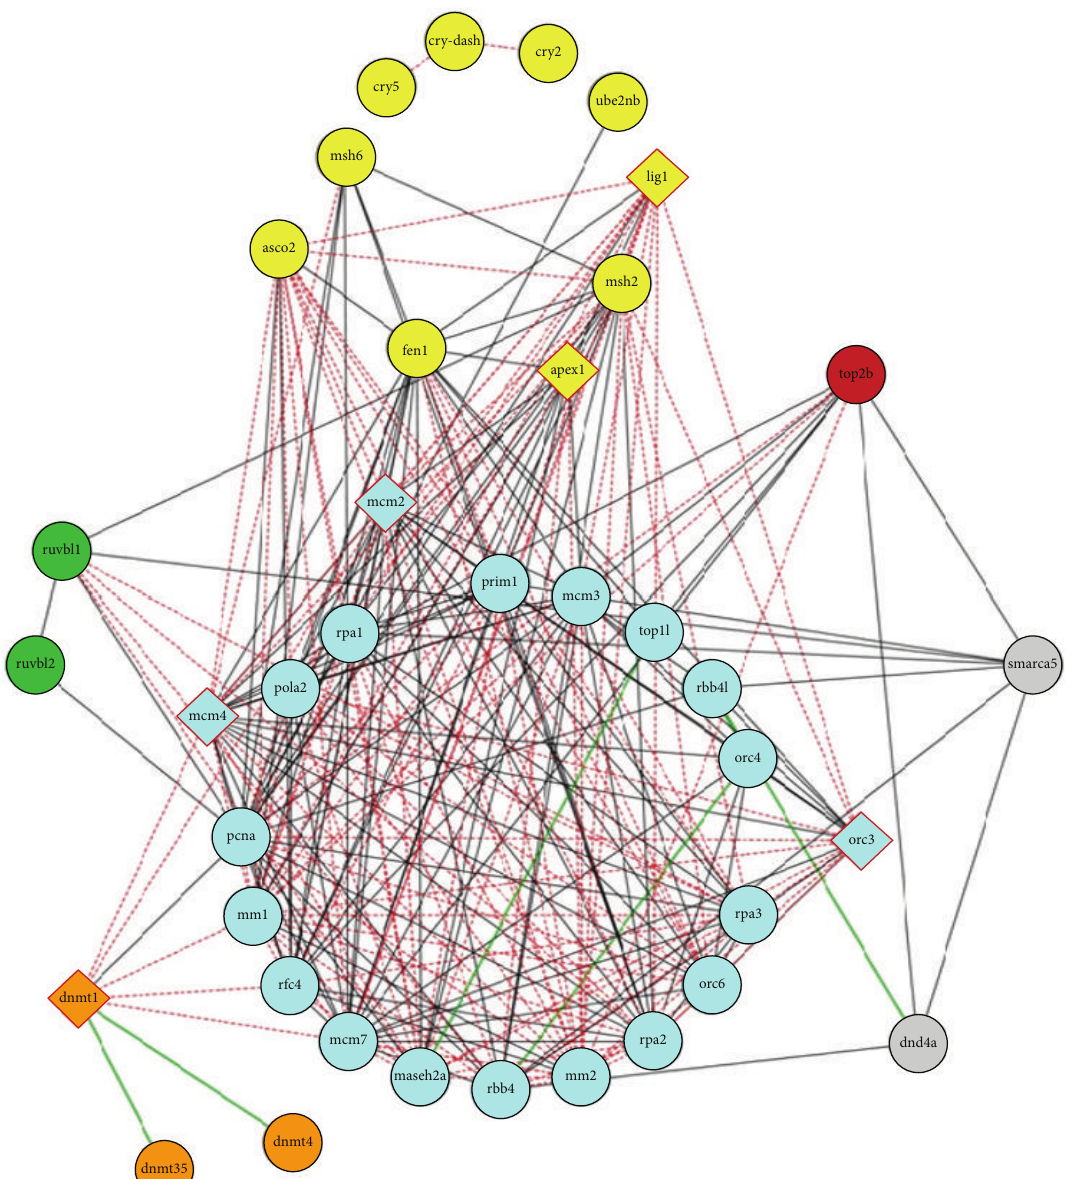
Figure 2: Gene network showing associations between genes that were differentially expressed in the DM and MM states relative to controls (genes of Figure 2 are listed in Supplemental Table 1). Nodes of the network represent genes that are grouped by their involvement in biological process as defined by the Gene Ontology and are colored accordingly (light blue denotes genes involved in DNA replication; gray, in chromatin remodeling; orange, in DNA methylation; green, in DNA recombination; yellow, in DNA repair; and brown, in DNA topological change). Diamond-shaped nodes represent genes with differentially methylated regions. Gene interactions confirmed experimentally and by coexpression are shown as black lines connecting nodes; red dotted lines show associations derived only from coexpression data; and green lines denote interactions confirmed by only experimental